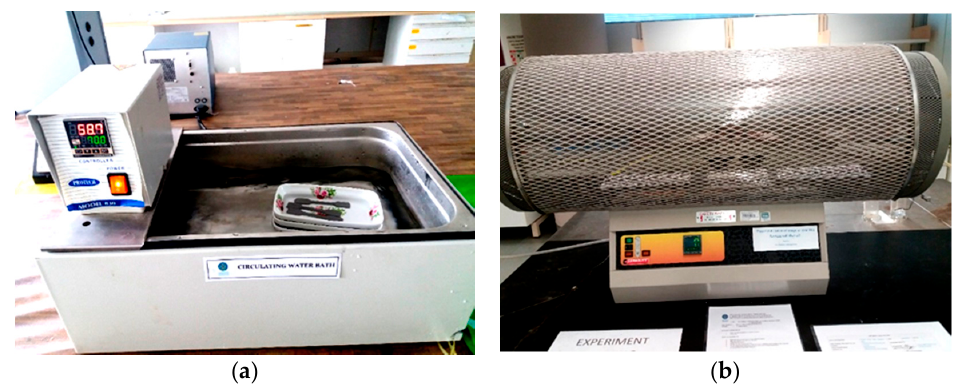
Figure 5. ( a ) Solvent de-binding of MIM green parts and ( b ) furnace for thermal de-binding and sintering of MIM brown parts.